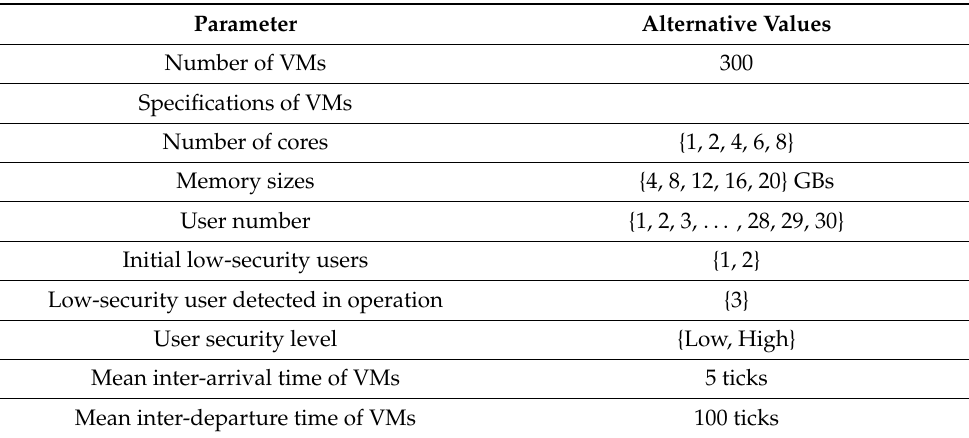
Table 2. Load-related parameter for experiments.